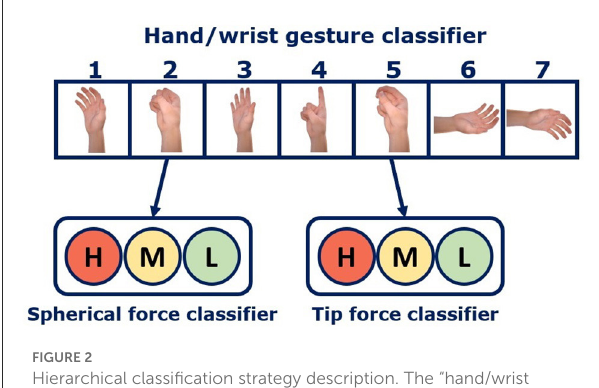
FIGURE2 Hierarchical classification strategy description. The “hand/wrist gestures classifier” outputs are represented by these seven different gestures: 1, Rest; 2, Spherical; 3, Platform; 4, Point; 5, Tip; 6, Supination; 7, Pronation. If its output class is “spherical”, the “spherical force classifier” will work simultaneously to classify the three force levels (H = High, in red; M = Medium, in yellow; L = Low, in green). Likewise for tip.